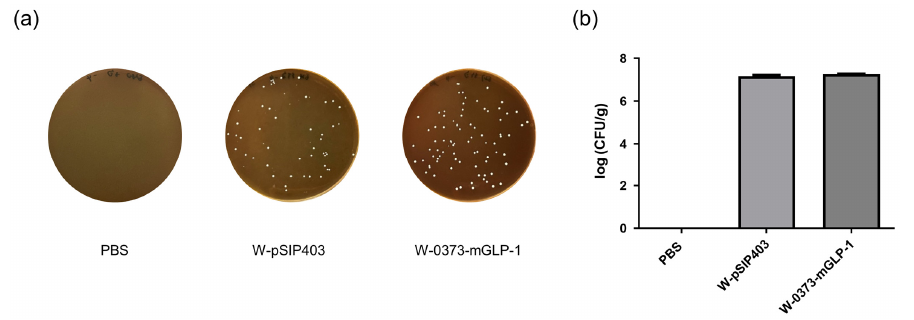
Figure 10. The density of the vehicle probiotics in the colorectum of treated db/db mice. ( a ) Plate-grown colonies of W-pSIP403 and W-0373-mGLP-1; ( b ) CFU of the vehicle probiotics in the colorectum. Each bar represents the average of the log-transformed count of colonies ± SD.